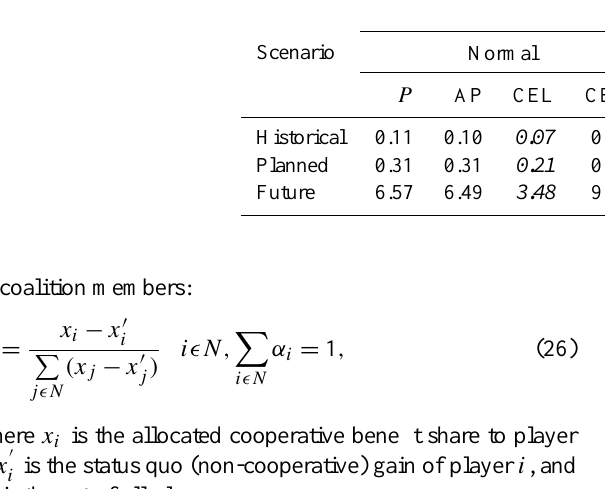
Table 2. Bankruptcy allocation stability index (BASI) values of different bankruptcy solutions for different claims and hydrologies. BASI Scenario